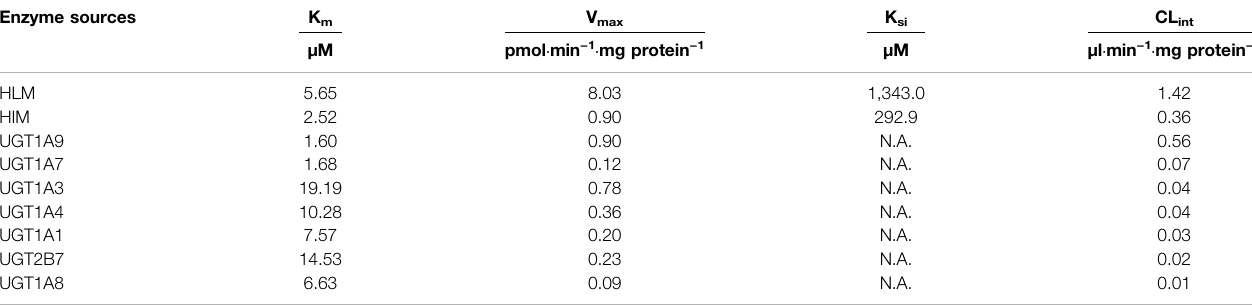
TABLE 1 | Kinetic parameters for ticagrelor glucuronidation by HLM, HIM and recombinant human UGT isoforms. Enzyme sources